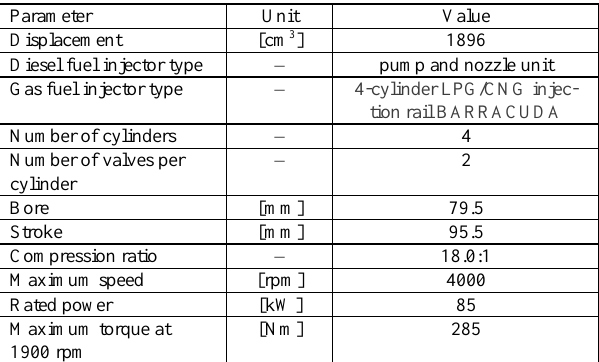
Fig. 9. Test bench schema Table 5. Base engine